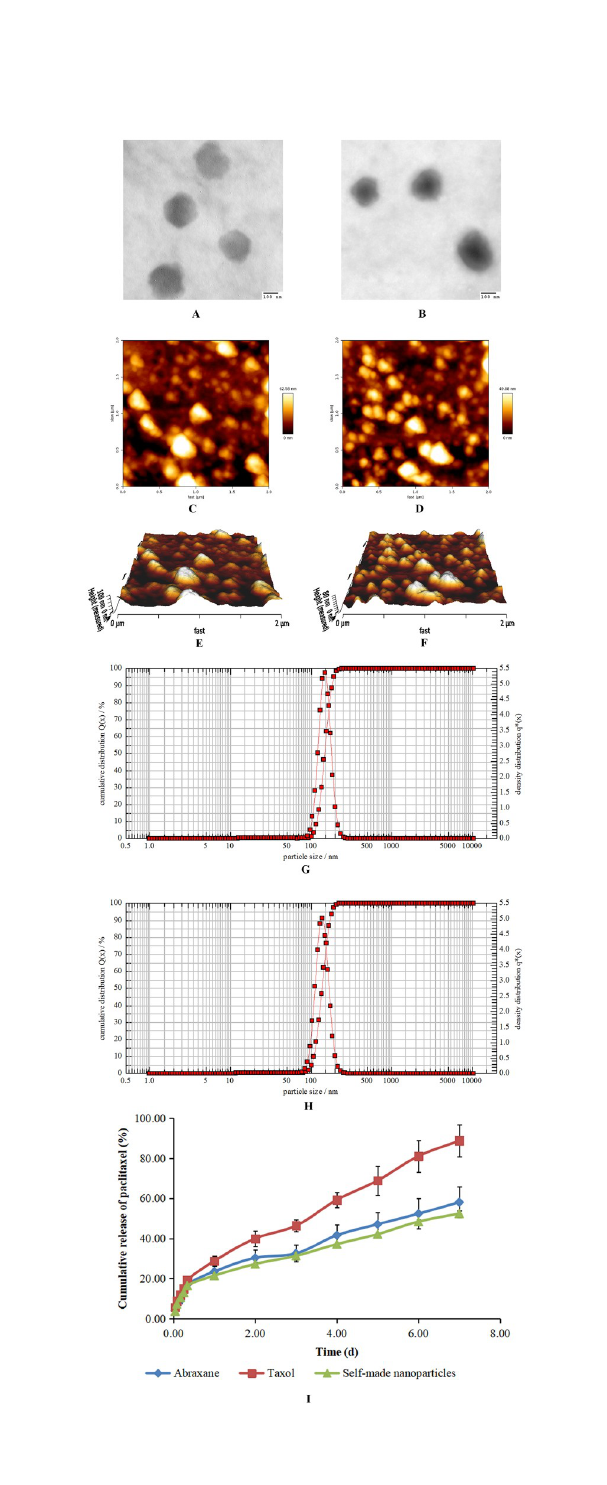
Fig 3. Characterization of paclitaxel nanoparticles. (A) TEM image of Abraxane. (B) TEM image of self-made nanoparticles. (C) AFM plane surface image of Abraxane. (D) AFM plane surface image of self-made nanoparticles. (E) AFM 3D image of Abraxane. (F) AFM 3D image of self-made nanoparticles. (G) Particle size distribution of Abraxane. (H) Particle size distribution of self-made nanoparticles. (I) Cumulative release profiles of paclitaxel from Taxol, Abraxane and self-made nanoparticles in PBS (pH7.4) containing 0.05% Tween 20 and 0.05% Tween 80 at 37˚C.